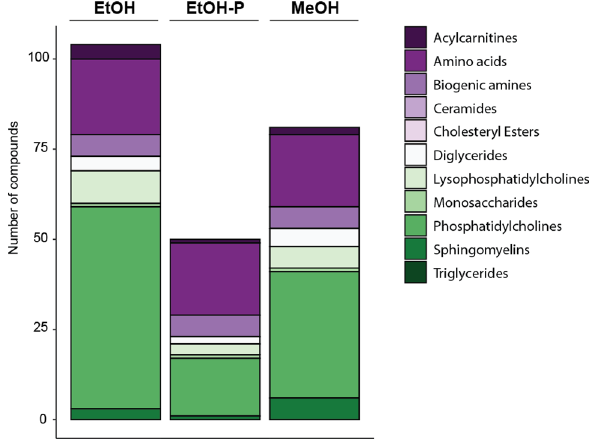
Figure 2. Number of detected compounds per biological group using different cell lysis solvents. Five replicates were measured in each condition; outliers were removed from the final analysis as described in the materials and methods. A strict noise threshold filter was applied to data such that in some cases, compounds were detected but filtered out before these results were compiled.